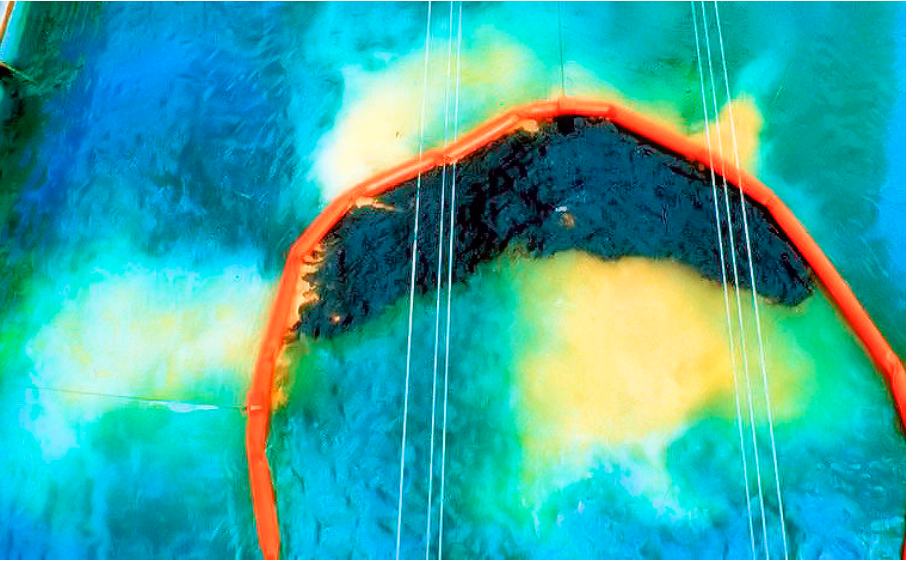
Figure 7. The appearance of a coffee-colored plume after the application of a chemical dispersant to crude oil in a test tank. This photo was taken about 20 min after the application of a dispersant. This coffee-colored plume is the result of light reflection from droplets of oil in the water in the size range of 5 to 50 µm.